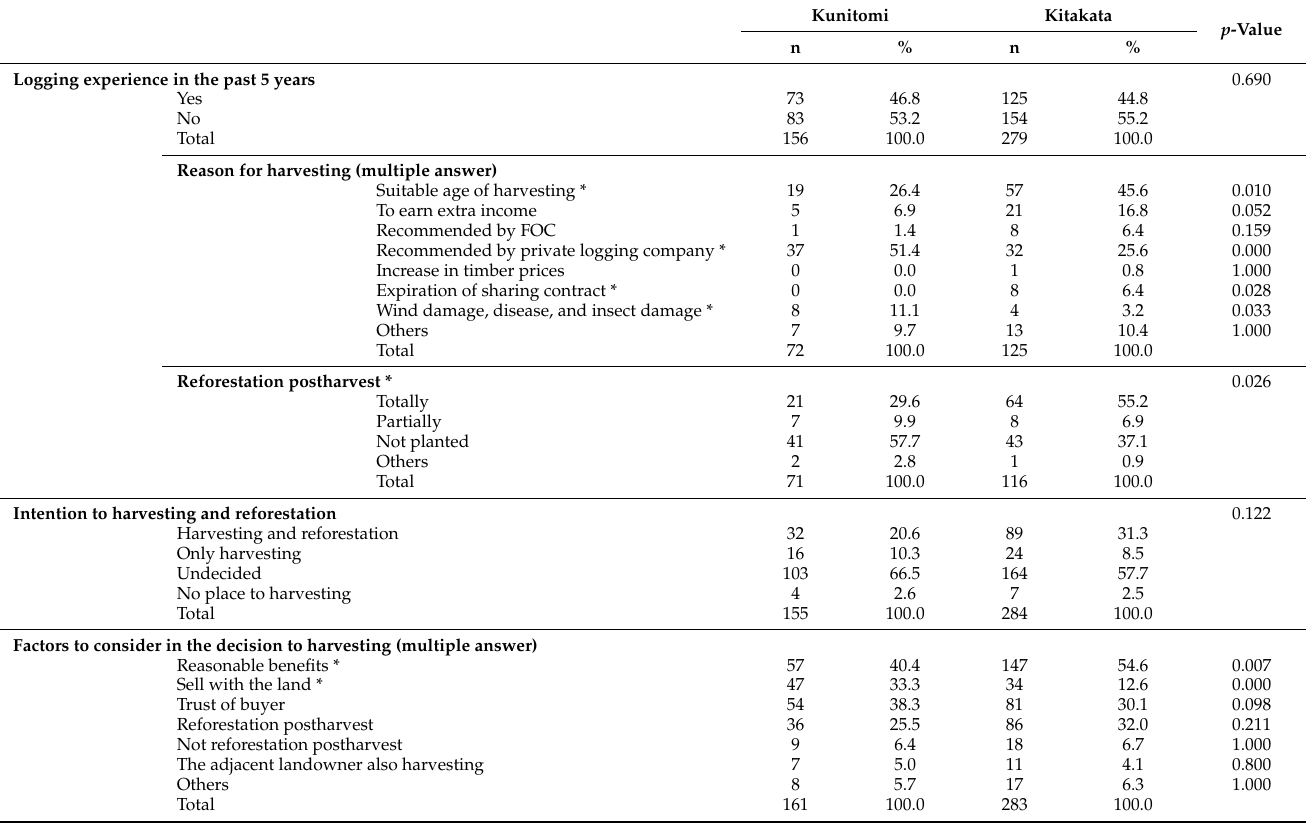
Table 3. Comparison of reasons for harvesting/reforestation and harvesting decisions between the two